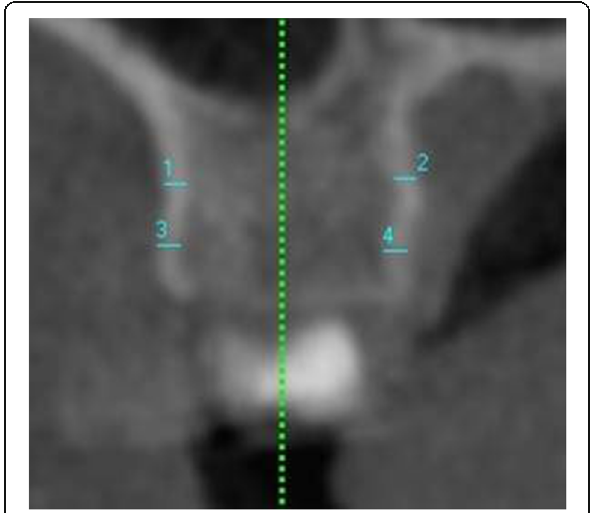
Fig. 3 Coronal section through the inter-radicular area between upper right first and second molars. Buccal cortical plate thickness at 4 mm (measurement 3 ) and at 7 mm (measurement 1 ) apical to the crest of the alveolar bone. Palatal cortical plate thickness at 4 mm (measurement 4 ) and at 7 mm (measurement 2 ) apical to the crest of the alveolar